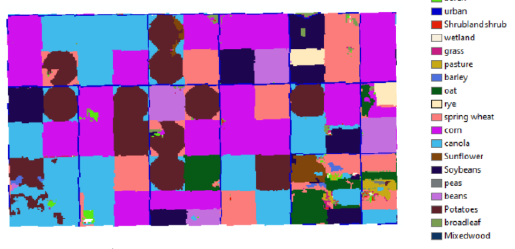
Figure 7 . Ground truth with Legend